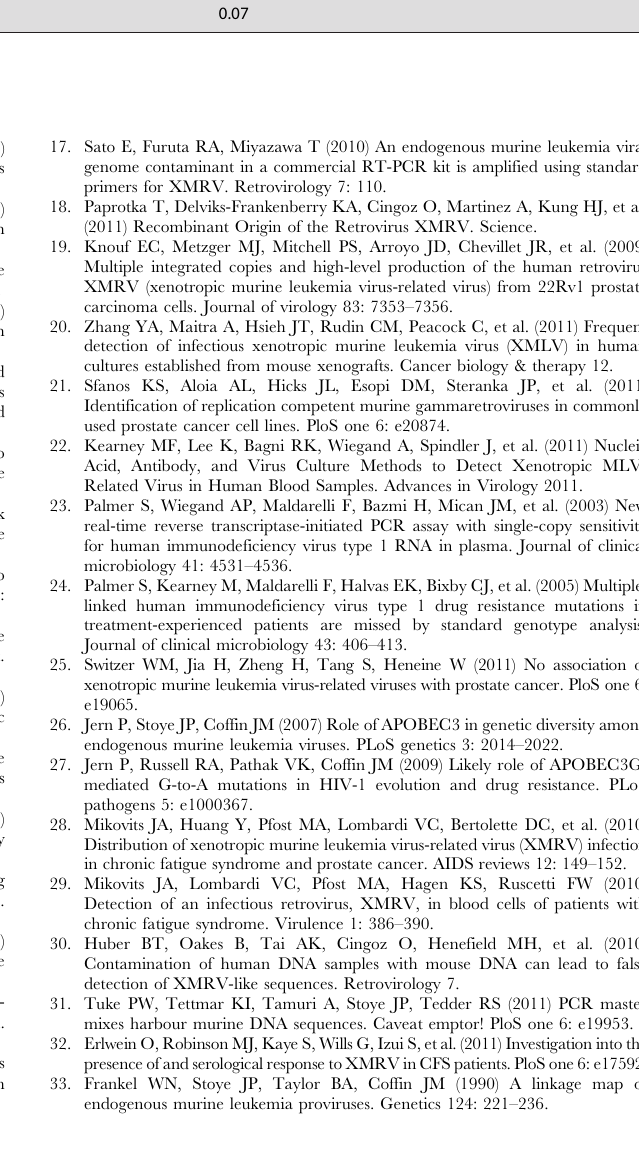
PID % Intra-patient diversity a % Distance from 22Rv1 consensus